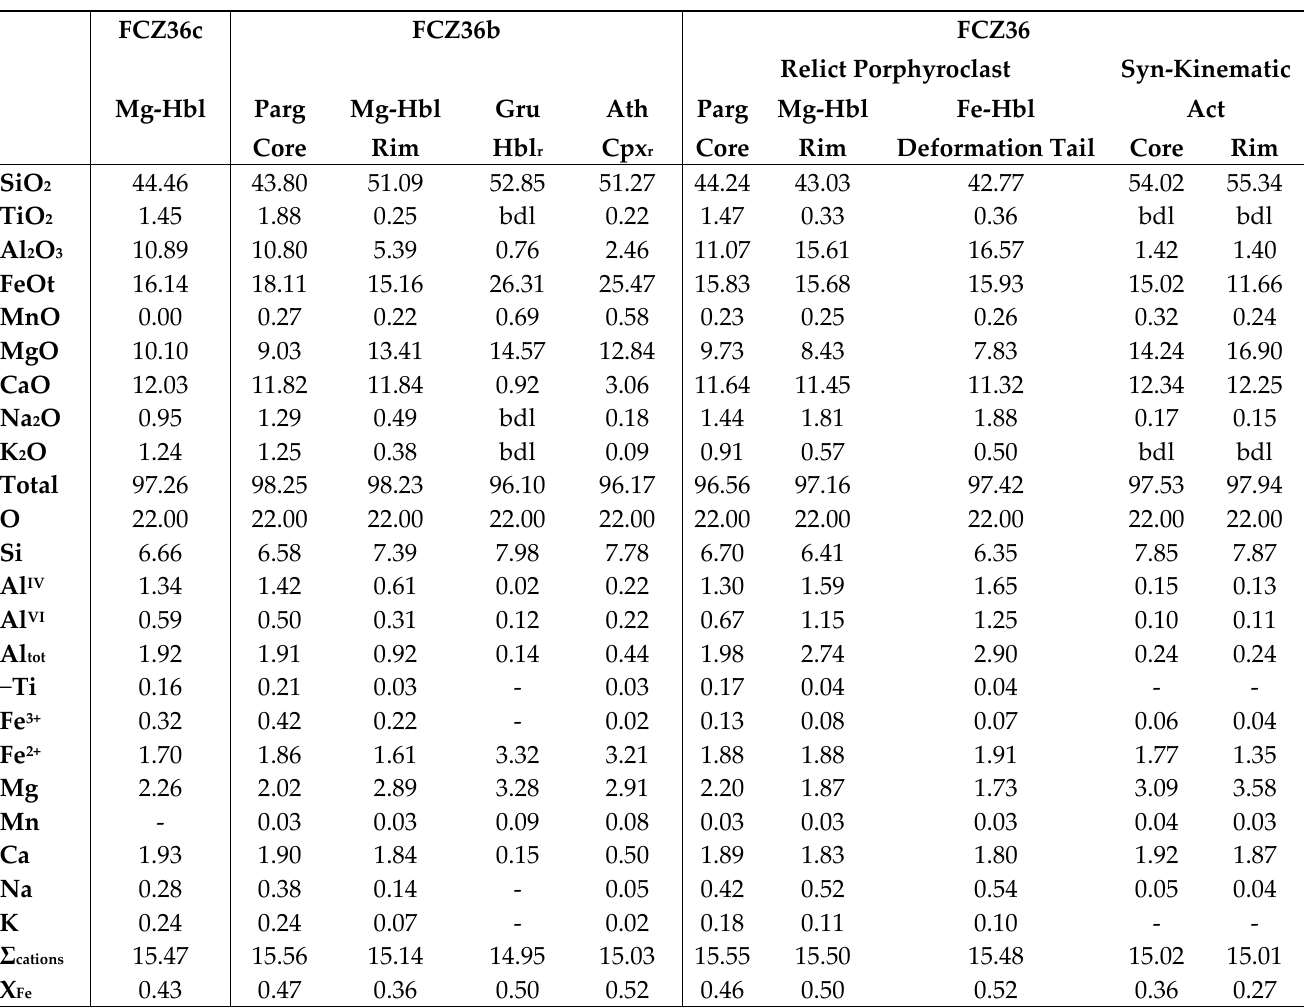
Table 4. Representative analysis of amphiboles in metabasite samples; “bdl” is an abbreviation for “below detection limit”.